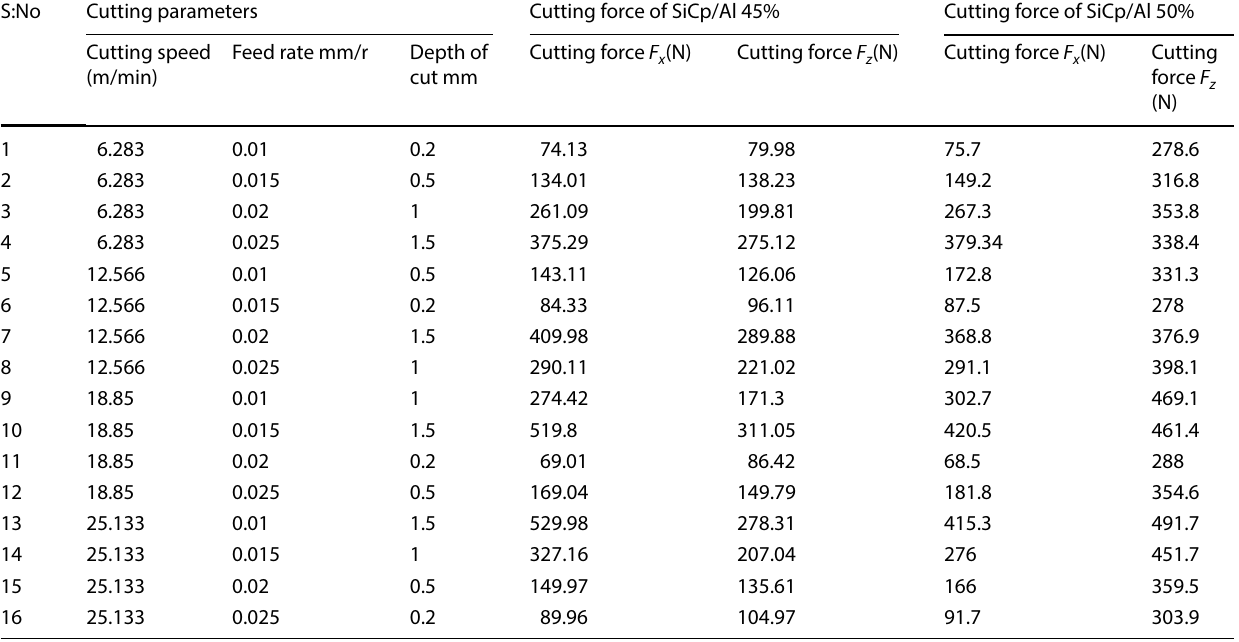
Table 2 Selected Cutting Parameters for Cutting Force SiCp/Al45% [40] and 50% S:No Cutting